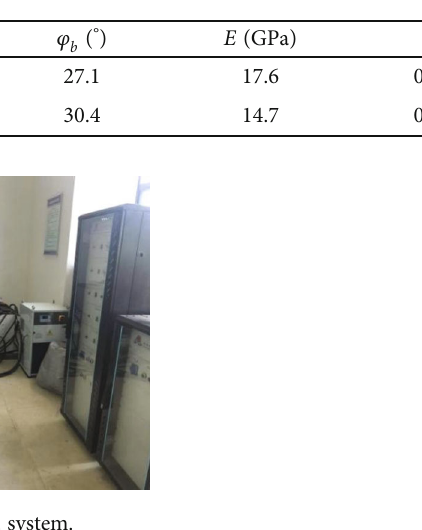
Figure 1: Granite joint using splitting method. Table 2: Physical and mechanical parameters of the granite and UHPC.